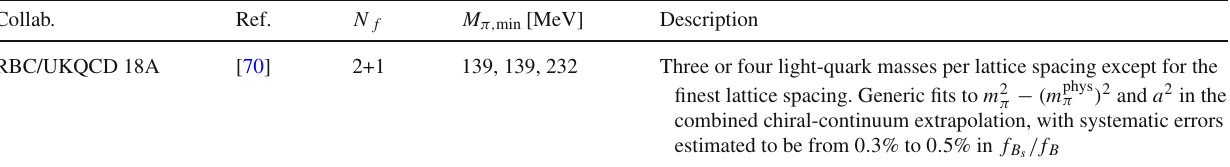
Table 140 Chiral extrapolation/minimum pion mass in determinations of the B - and B s -meson decay constants for N f = 2 + 1 simulations. For actions with multiple species of pions, masses quoted are the RMS pion masses. The different M π, min entries correspond to the different lattice spacings Collab.